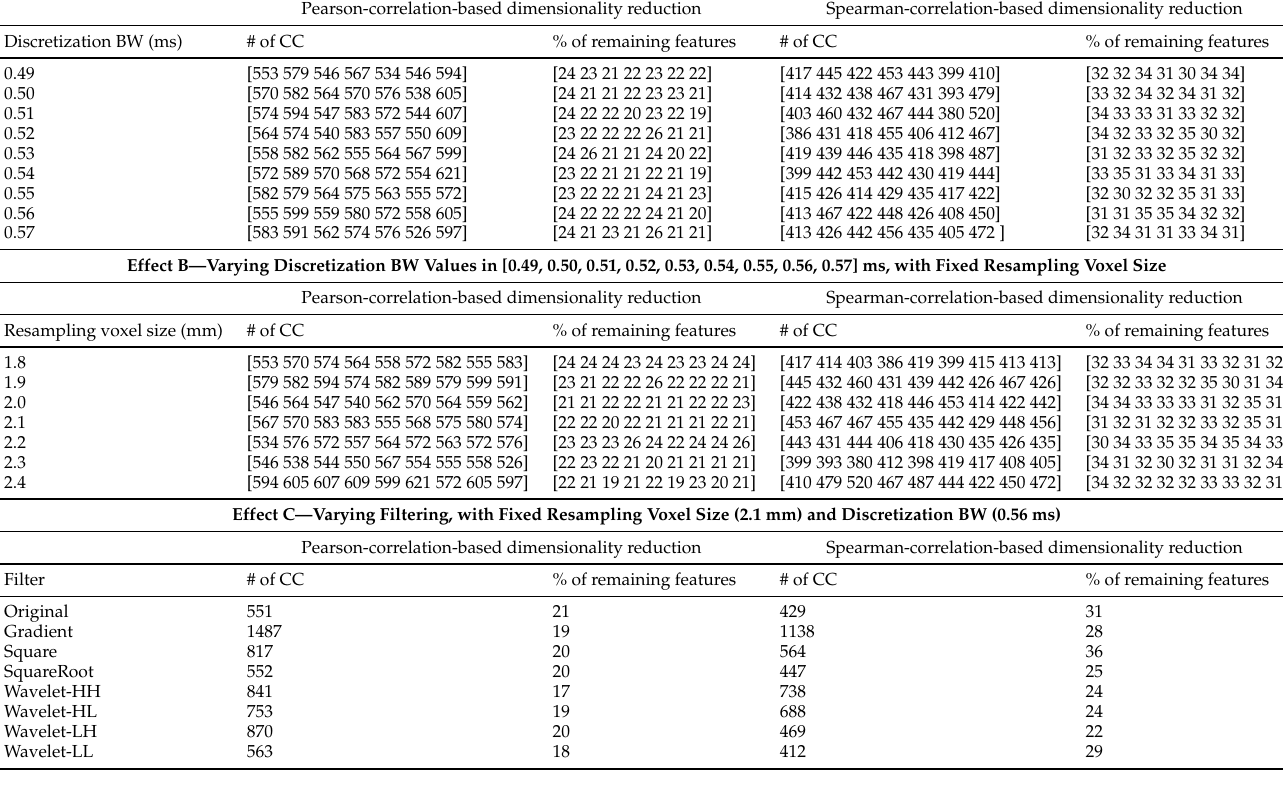
Table 5. Stability indices for T2